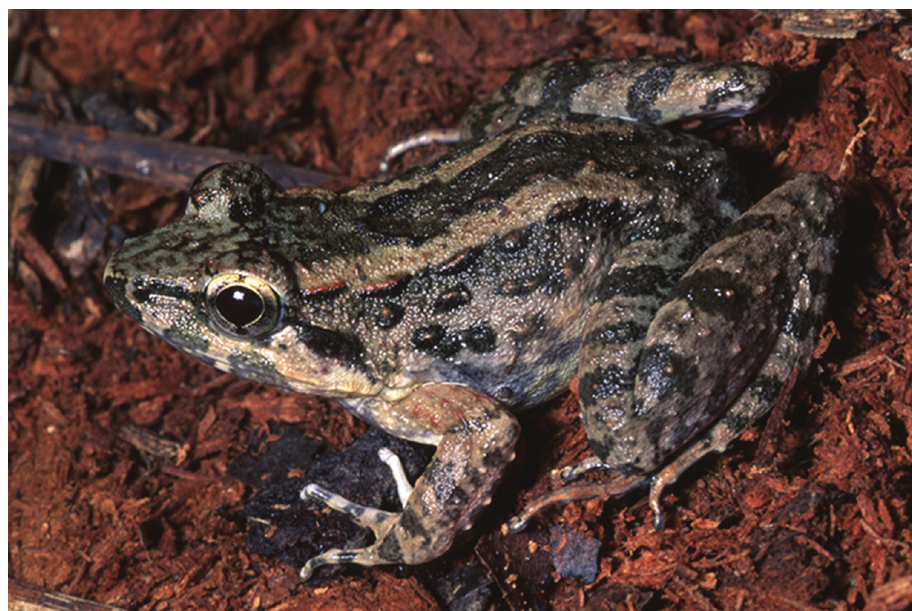
Figure 14. Limnonectes leytensis has been collected in Bunawan, Agusan del Sur Province and on Dinagat Island. Photo: RMB (from Bohol; KU 326352).